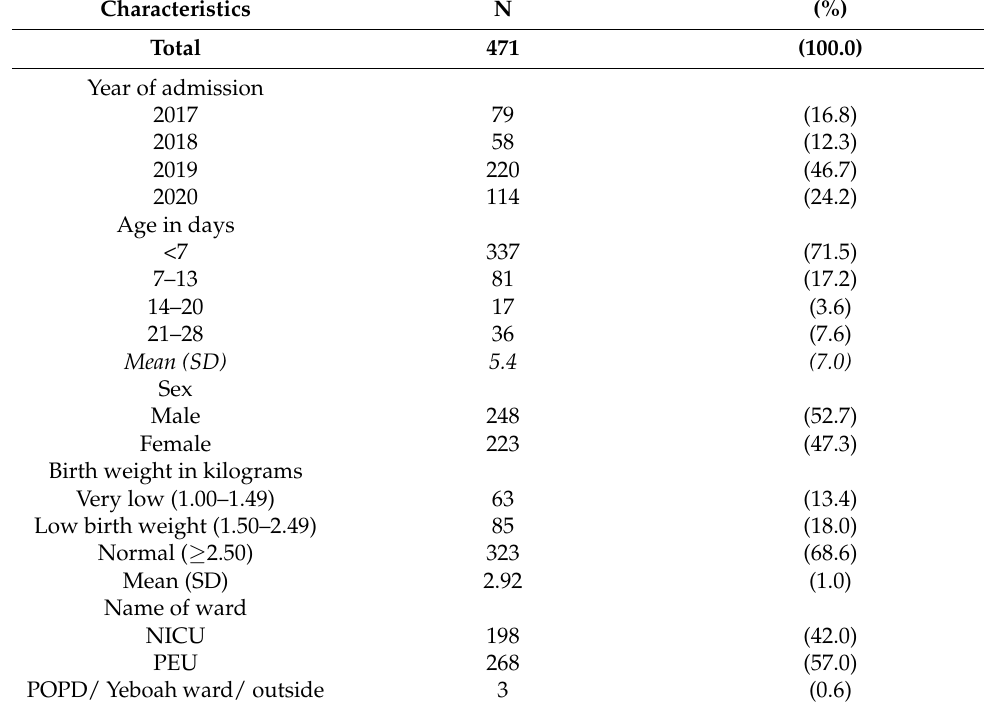
Table 1. Baseline characteristics and exit outcomes of neonates with suspected sepsis who underwent culture and antibiotic sensitivity testing at the 37 Military Hospital, Accra, Ghana (2017–2020).